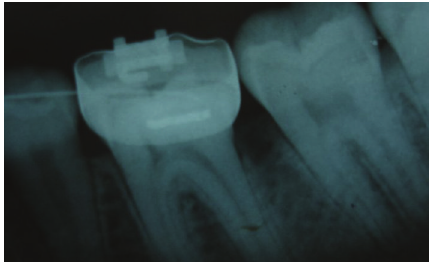
Figure 4: Radiographic view one month following treatment demonstrating damage to the alveolar bone between the first and second lower left